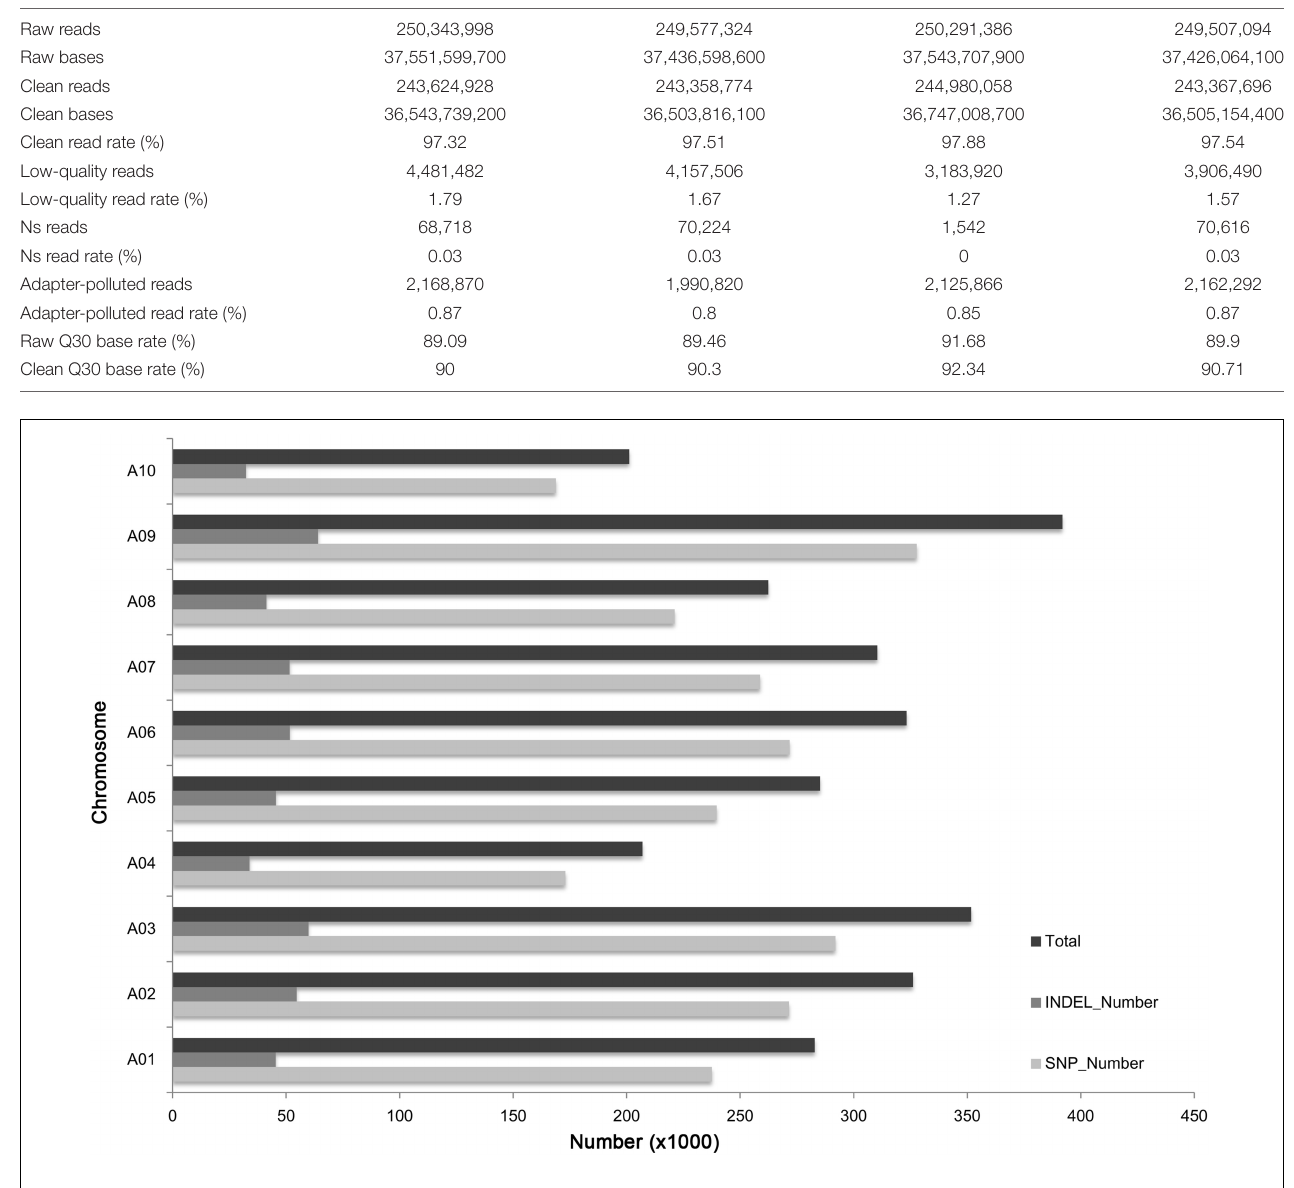
FIGURE 1 | Distribution of SNPs and InDels on each